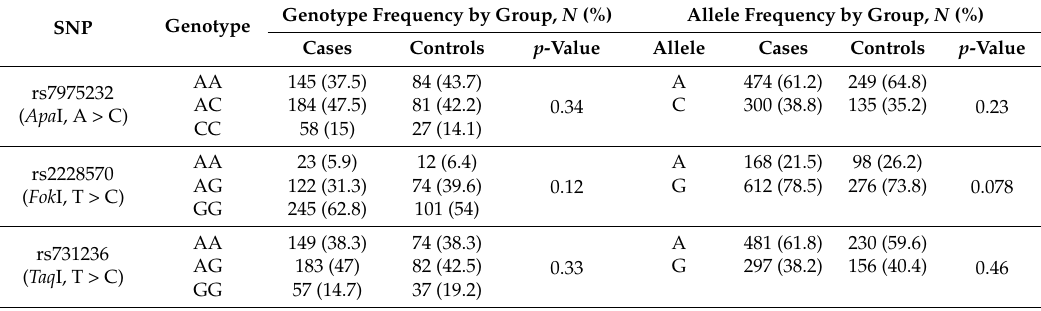
Table 2. Comparison of the genotype and allele frequency distribution between breast cancer patients and healthy controls.